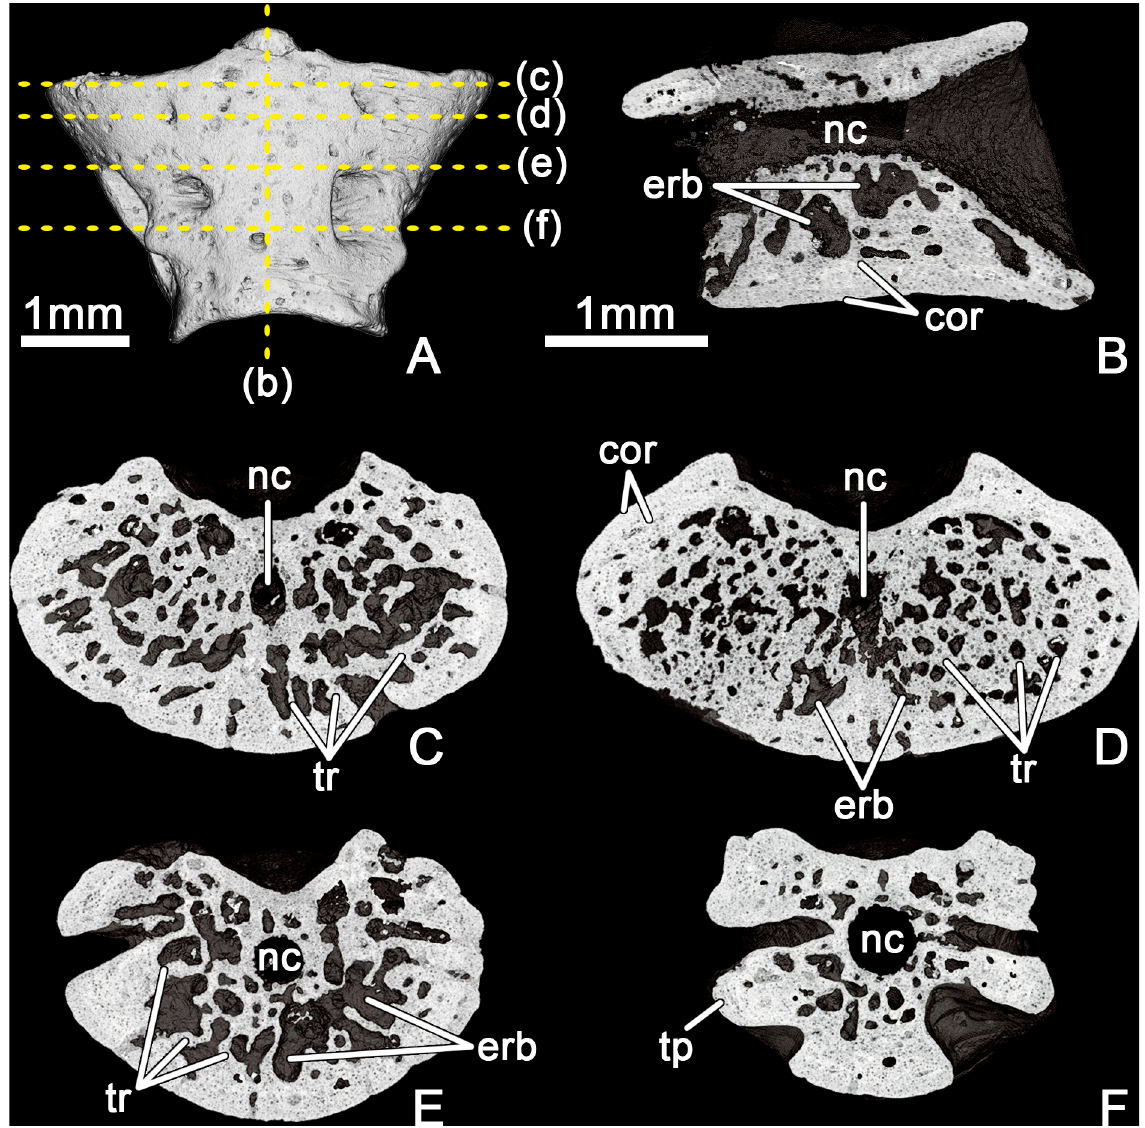
Fig 3. Egoria malashichevi gen. et sp. nov., digital restoration of atlantal centrum ZIN PH 40/144 (holotype), entire specimen in ventral view (A), showing locations of microCT digital sections: longitudinal section in vertical plane (B) and transverse sections from anterior to posterior (C–F). Abbreviations: cor–cortex, erb–erosion bay, nc–notochord canal, tp–transverse process, tr–trabecular bone. All images showing digital sections at same